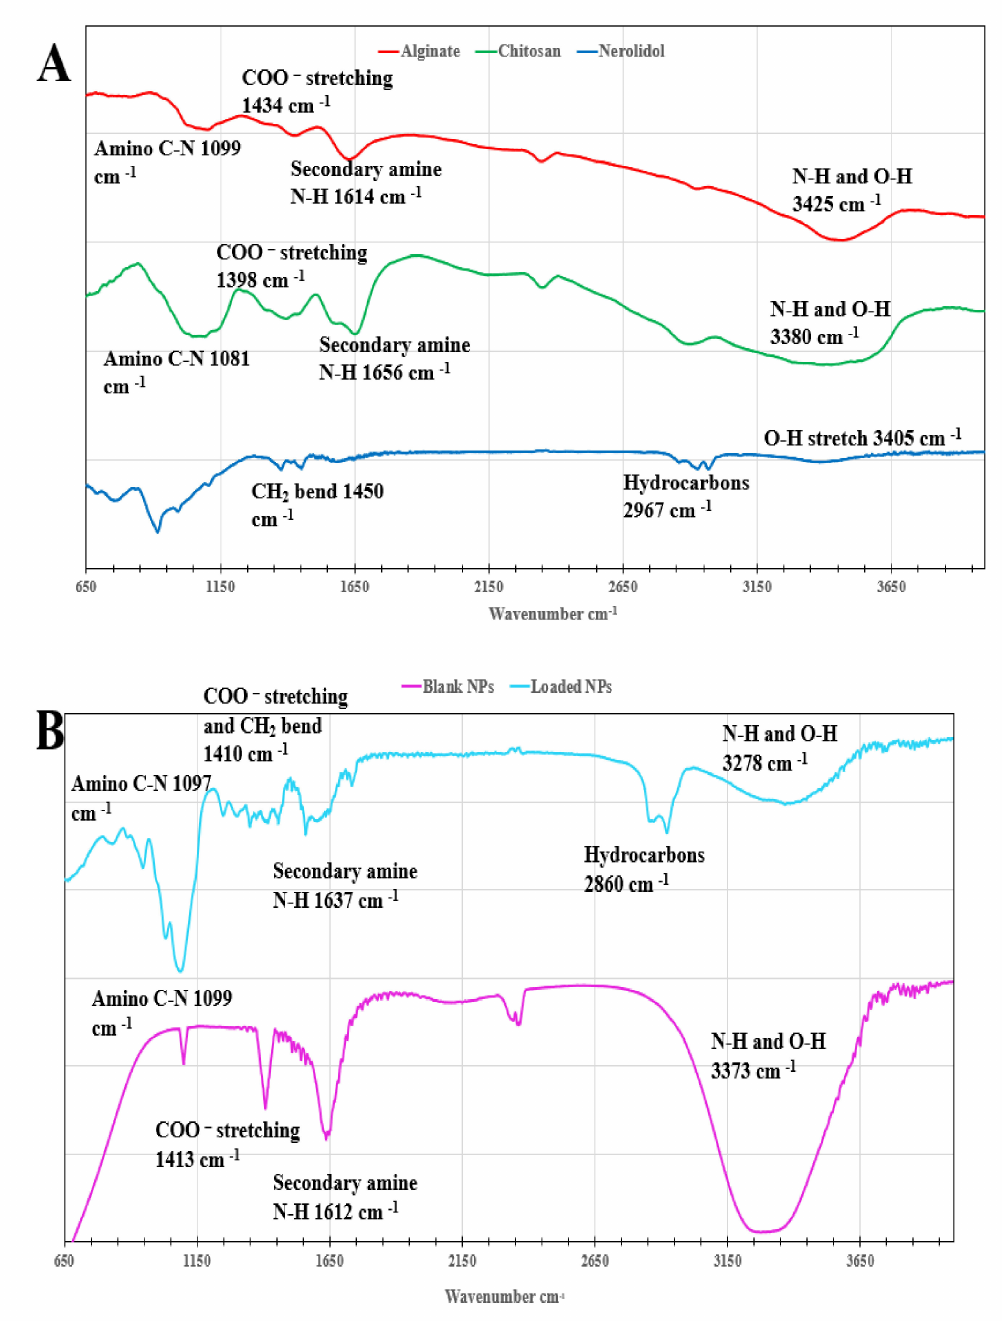
Figure 2. ( A ) The Fourier transform infrared spectrometry (FTIR) of the starting materials and ( B ) the band shifts in the blank and nerolidol-loaded chitosan-alginate nanoparticles. Correspondingly, in the chitosan–alginate nanoparticles and the nerolidol-loaded chitosan–alginate nanoparticles, the peak absorbance of the amino groups, carboxyl groups, secondary amine groups, and the amine and hydroxyl stretching vibrations showed a minor shift following complexation. These results indicate that the carboxylate group of the alginate successfully interacted with the protonated chitosan amino group by electro- static attraction. Additionally, in the nerolidol-loaded chitosan–alginate nanoparticles, the alcoholic hydroxyl stretch and the symmetric hydrocarbons band showed a minor shift. These band shifts confirm the presence of an interaction between the nanoparticles complex and the